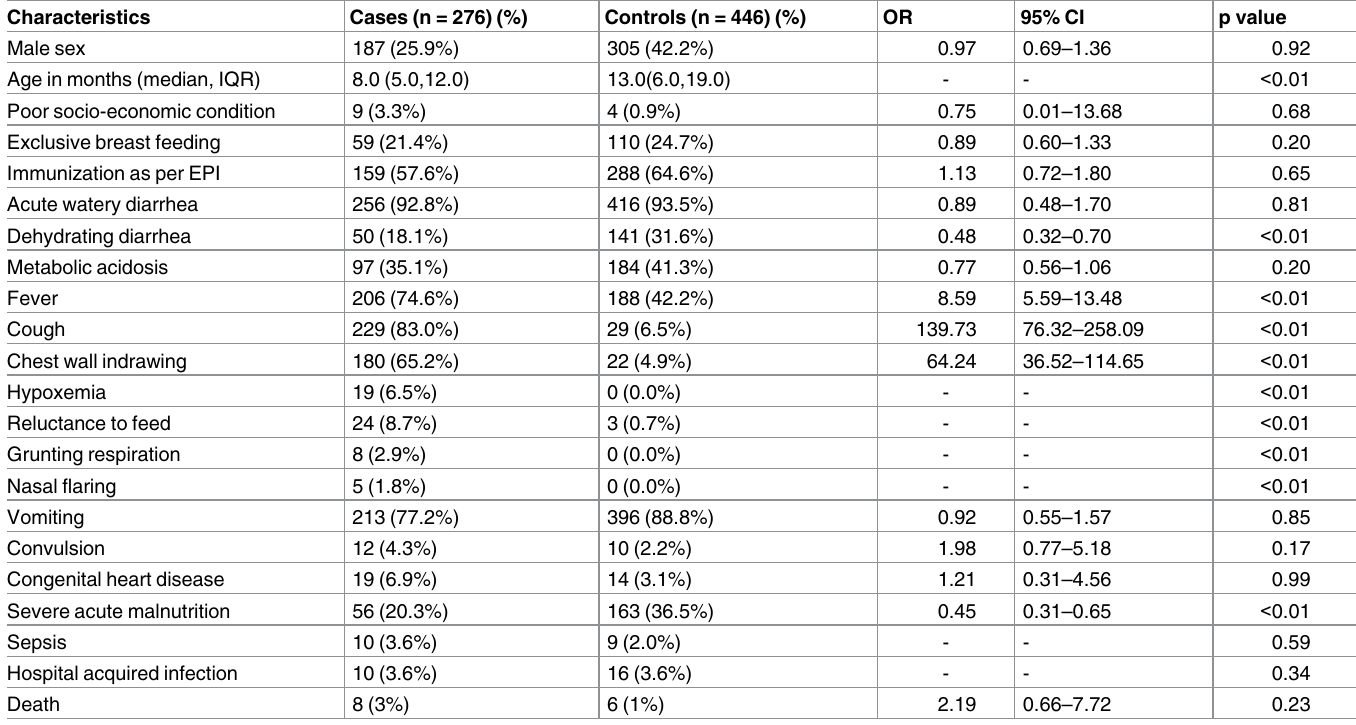
Figures represent n (%), unless specified. OR: odds ratio. CI: confidence interval. IQR: inter-quartile range. EPI: Expanded Program on Immunization; SD: